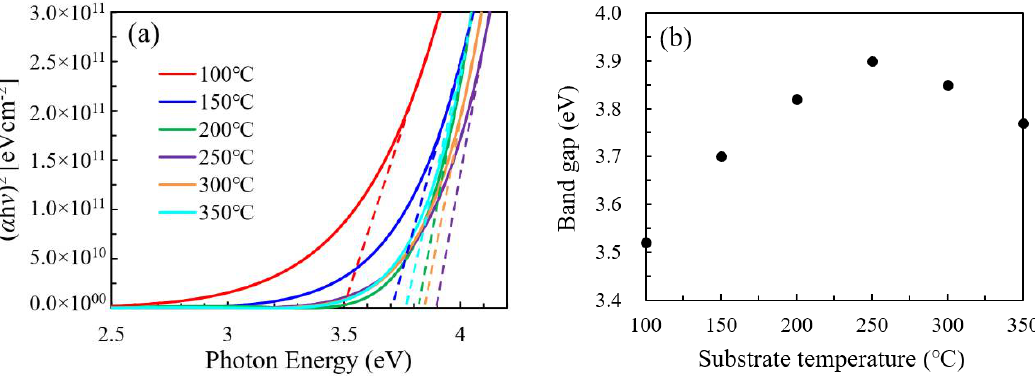
Figure 10. ( a ) Tauc plots and ( b ) optical band gap for the In 2 O 3 films deposited at different substrate temperatures.